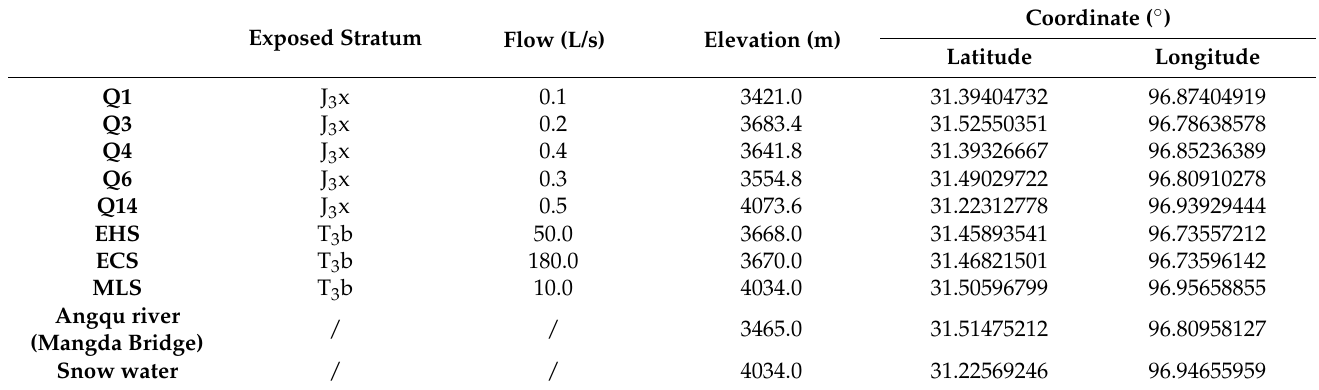
Table 1. List of isotopic sampling points.